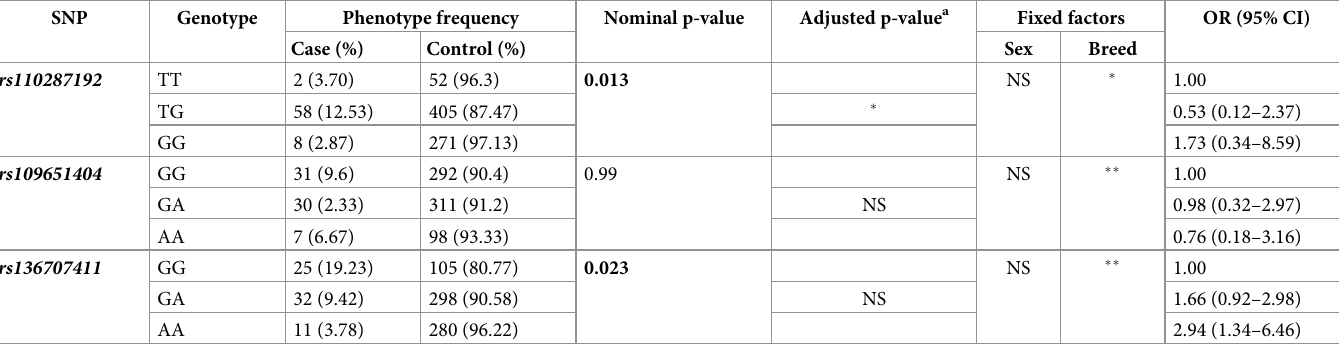
Table 2. Univariate logistic regression analysis of studied bovine EDN2 variants and independent factors associated with pTB cases and controls.